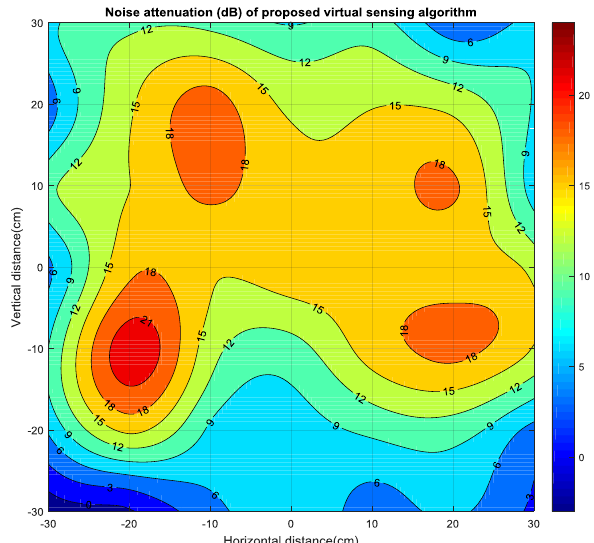
Figure 10. The quiet zone generated by multichannel ANC with the proposed virtual sensing algorithm in the varying environment.